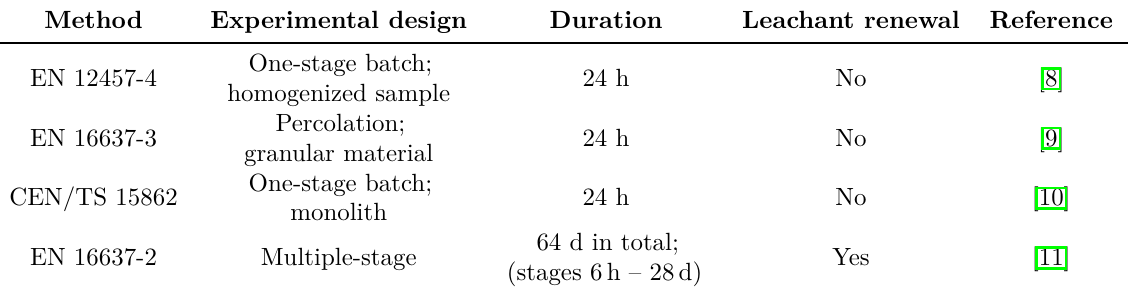
Table 1. Leaching standards used for characterization of construction materials, products, and